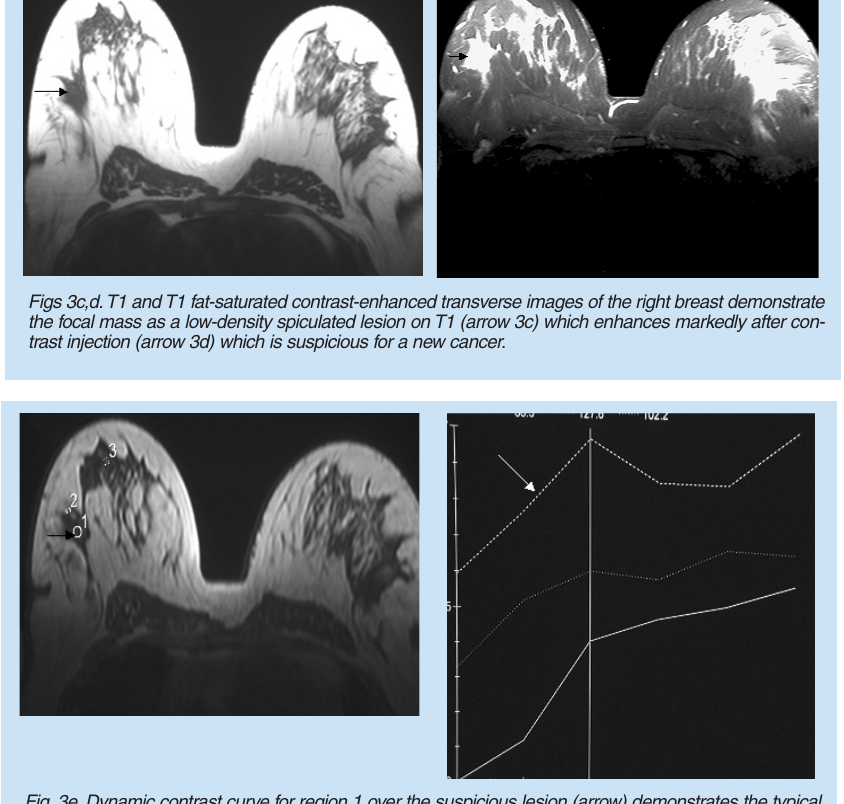
Fig.3e.Dynamic contrast curve for region 1 over the suspicious lesion (arrow) demonstrates the typical curve for a cancer with a rapid initial rise and slow washout of contrast with